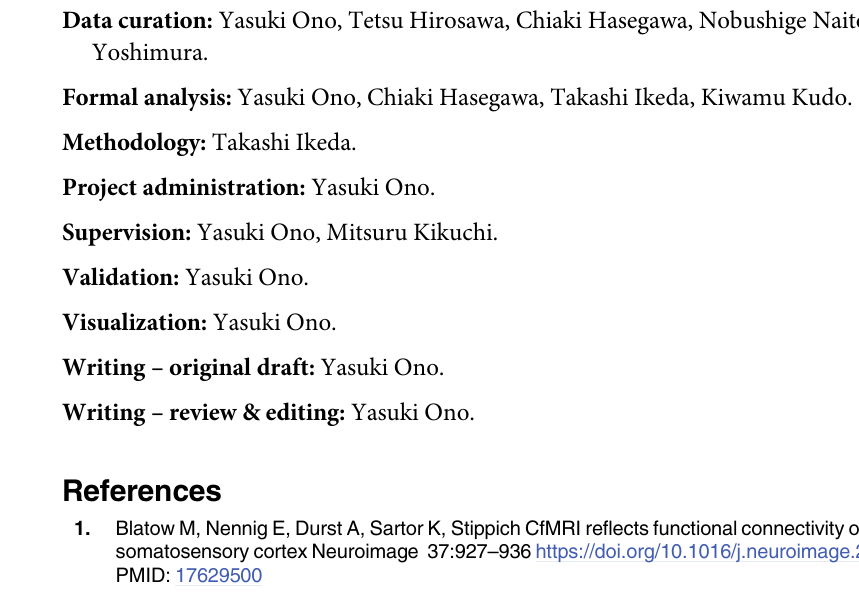
S3 Fig. Grand average of the event- related spectral perturbation (ERSP) for all subjects in the bilateral precentral and postcentral gyri during moving and static image observation after saline and oxytocin administration. The N30 component was accompanied by an increase in gamma phase locking in both the precentral and postcentral gyri in the left hemi- sphere. Paired-sample t-tests failed to identify significant differences in the ERSP in the bilat- eral precentral and postcentral gyri between moving and static image observations after oxytocin administration when the statistical threshold was set at p < 0.05 with false discovery rate corrections across ROIs, signals, and frequency dimensions. No significant differences were found in either the precentral or postcentral gyri when the statistical threshold was set at p < 0.05 with a false discovery rate